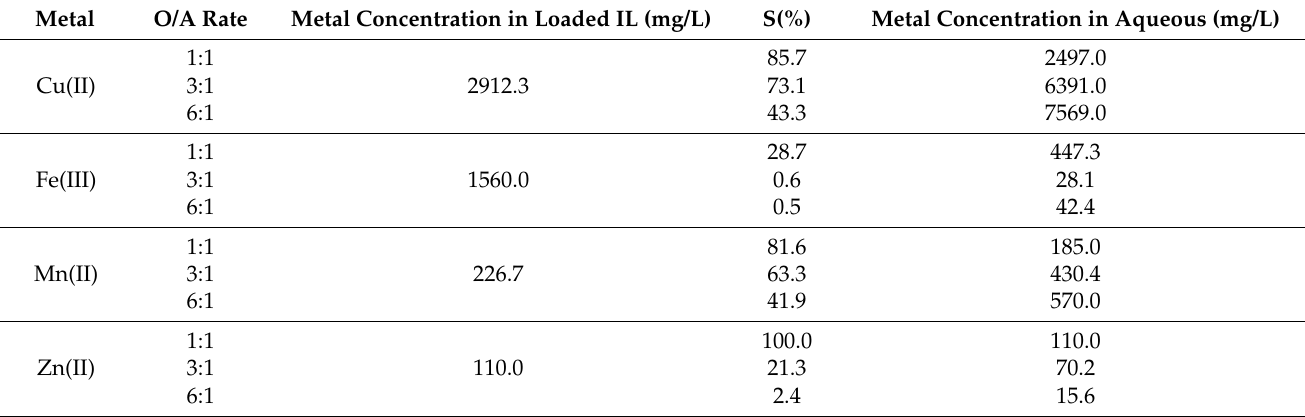
Table 3. Effect of O/A ratio on the stripping of metals from the organic loaded phase.